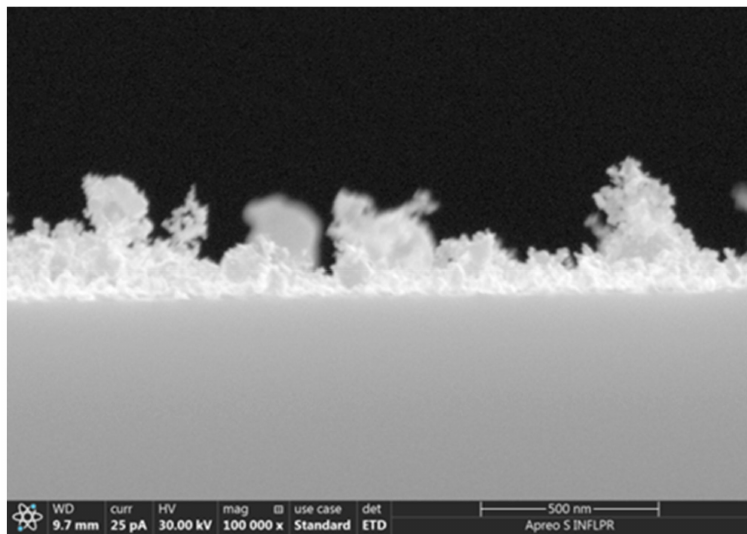
Figure 3. SEM image of the cross-section of a gold film deposited on Si at 4 Torr Ar pressure, using 30,000 laser ablation pulses. Corresponds to the film with the surface shown in Figure 2d. Scale bar is 500